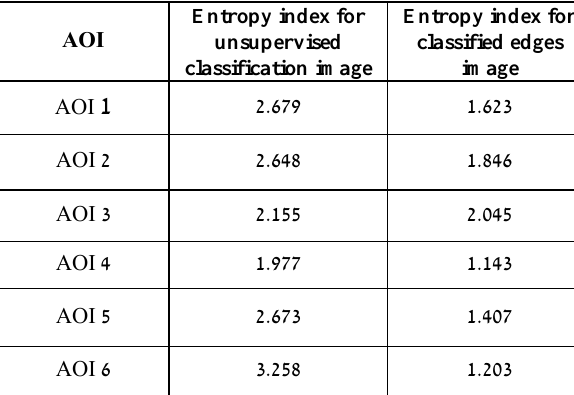
Table 4 : Entropy index for each test